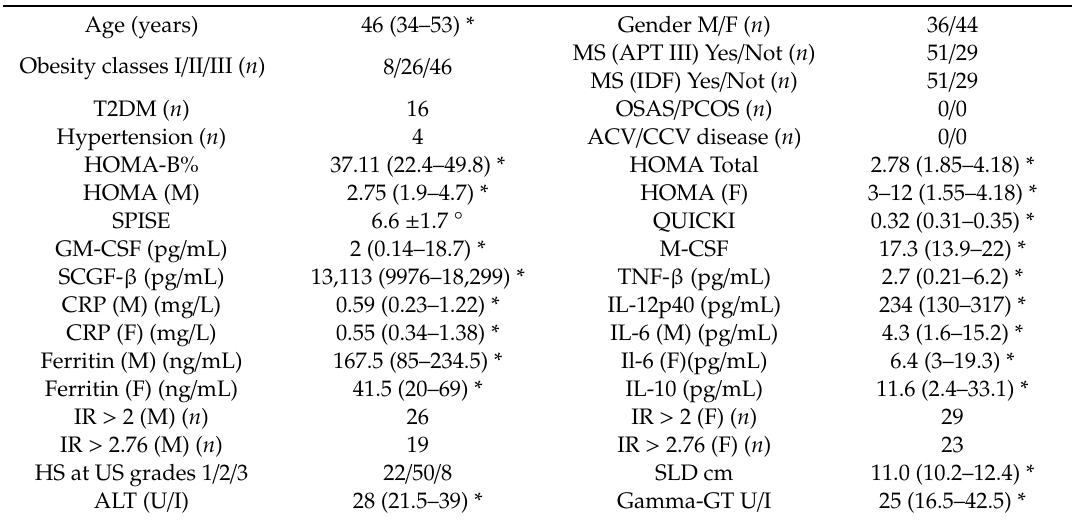
Table 1. Patient baseline data (clinical, laboratory and instrumental).